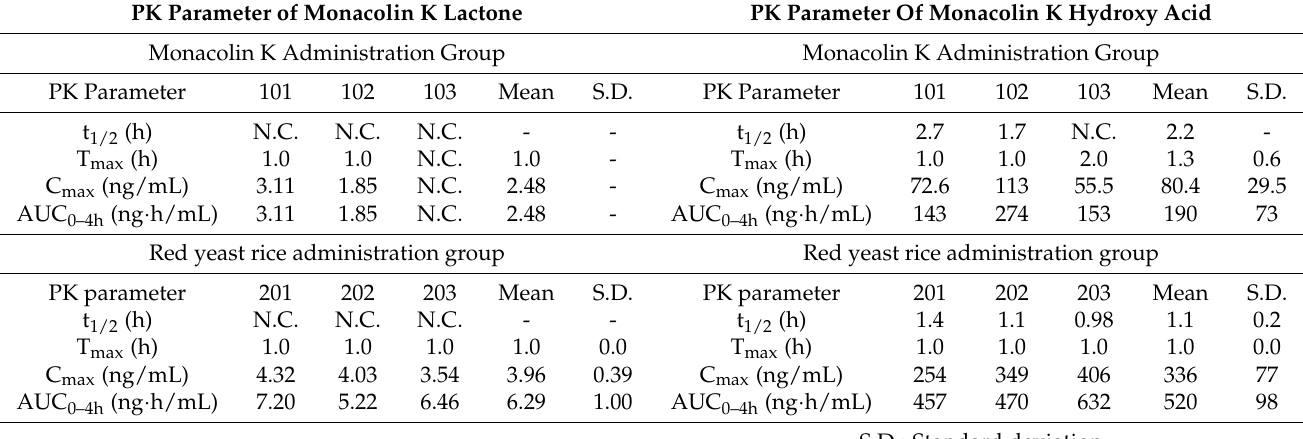
Table 3. Pharmacokinetic parameters of the lactone form and acid form of monacolin K in plasma after single administration of purified monacolin K or red yeast rice (40 mg/kg monacolin K or dose of red yeast rice equivalent to 40 mg/kg monacolin K). Peak analysis was performed according to the reference method [44].